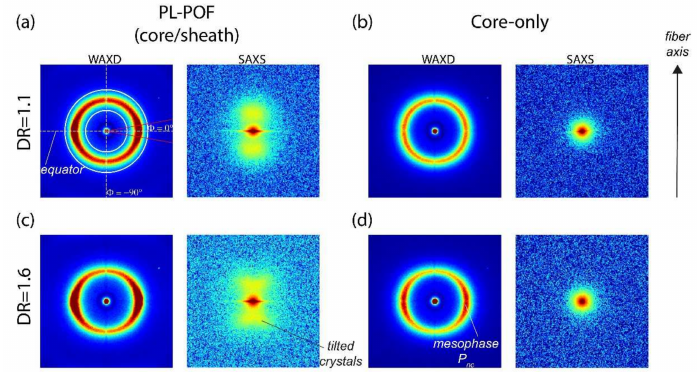
Figure 7. WAXD and SAXS patterns for ( a ) PL-POF with DR = 1.1 and corresponding ( b ) core-only fiber. WAXD and SAXS patterns for ( c ) PL-POF with DR = 1.6 and corresponding ( d ) core-only fiber. The fiber axis is